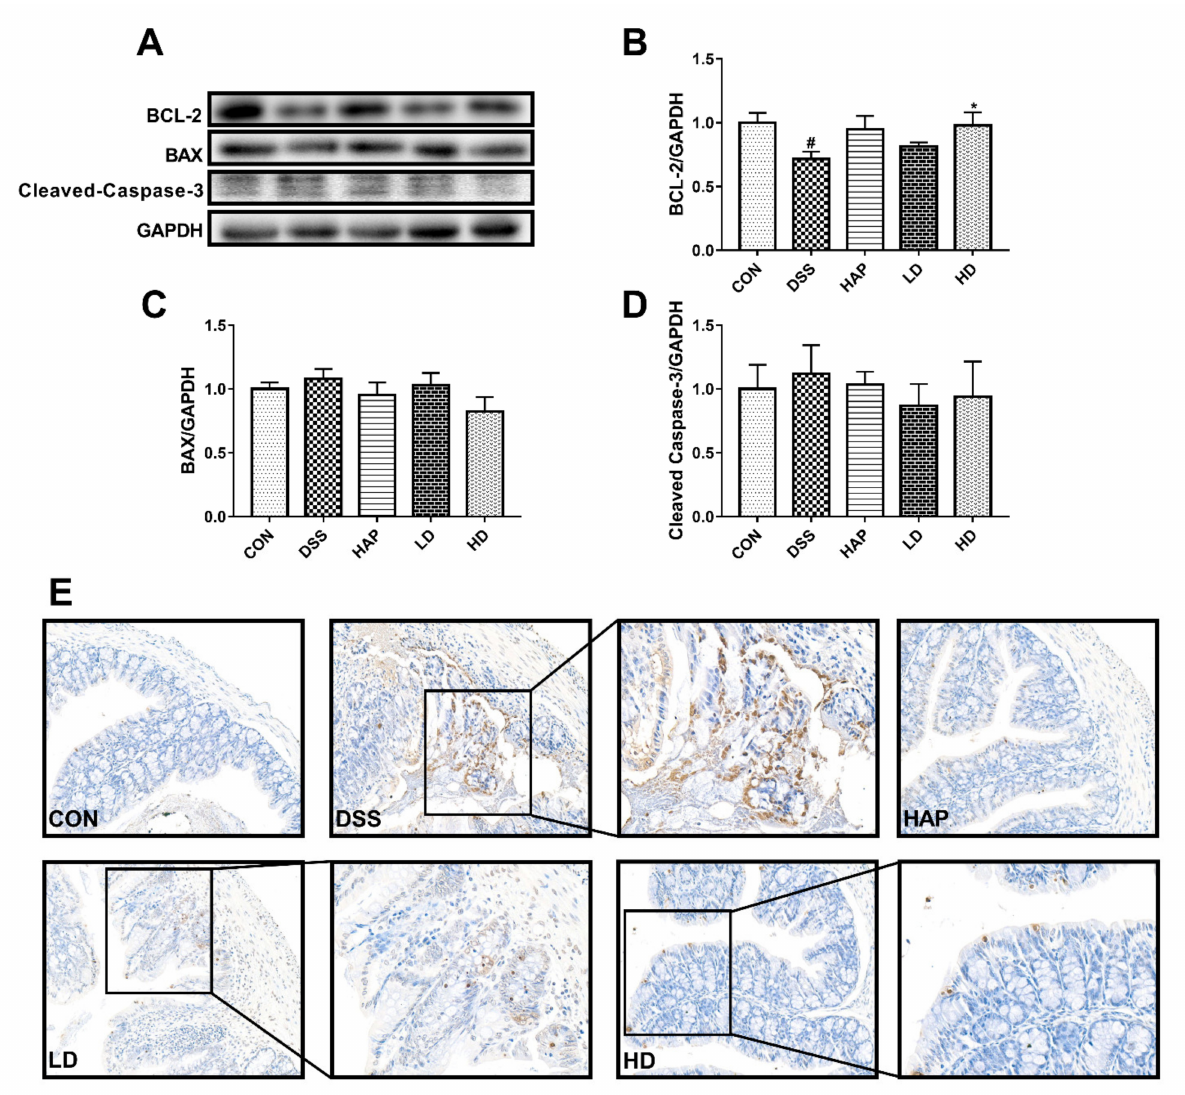
Figure 6. Effect of APE on intestinal epithelial cell (IEC) apoptosis: The levels of B-cell lymphoma 2 (BCL-2) ( B ), BCL2- associated X (BAX) ( C ) and Cleaved-Caspase-3 ( D ) in colon tissue were measured by Western blot ( A ). ( E ) Representative pictures of terminal deoxynucleotidyl transferase-mediated dUTP nick end labeling assay (TUNEL) staining. n = 8 or 9. # p < 0.05 vs. CON group. * p < 0.05 vs. DSS